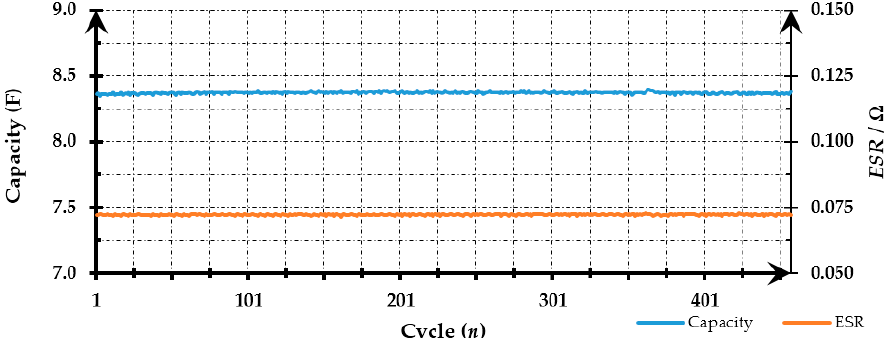
Figure 10. Charts illustrating variation in capacity ( C ) and equivalent series resistance ( ESR) values during test U = 3.3 V, I = 2800 mA.